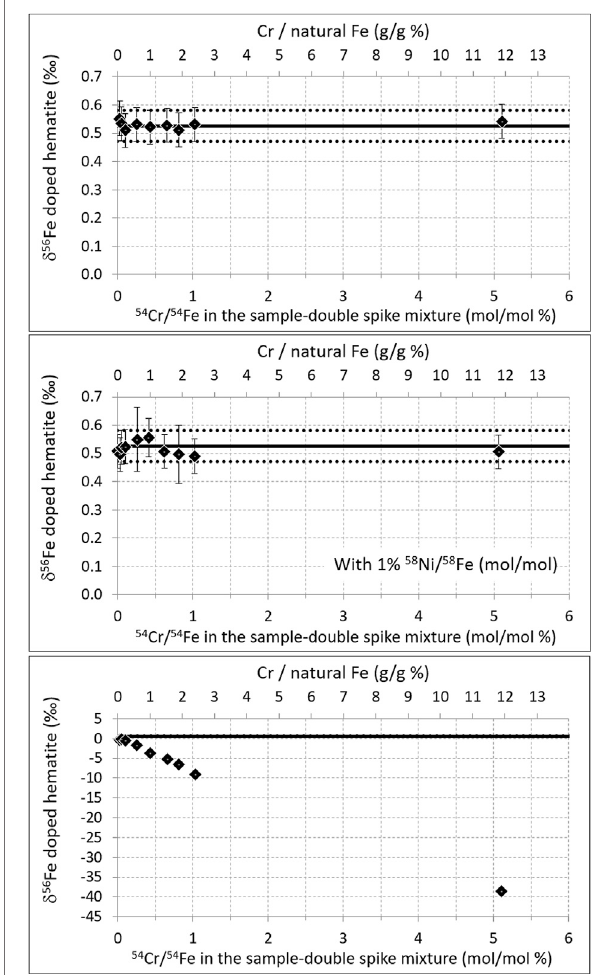
FIGURE 2 | Top: δ 56 Fe of hematite (200 ppb natural Fe) doped with variable amounts of Cr. Middle: same as top but with an addition of Ni leading to 1% 58 Ni/ 58 Fe (mol/mol) in all samples. Bottom: same as top but with no Cr interference correction (note the different vertical scale). The level of Cr doping is expressed in two ways: i) the level of Cr (all isotopes) compared to thatofnaturalFe(i.e.,nottakingintoaccountthedouble-spike,top x axis),and ii) the level of 54 Cr compared to 54 Fe in the analyzed solution, that is, in the sample double-spike mixture (bottom x axis). Diamonds are the averages of duplicate measurements (two Neptune analyses were performed for each data point reported on the plot). Error bars are 2 standard deviations of the duplicate measurements or the long-term internal precision (2SD) of our instrument (0.06 ‰ ), whichever the greatest (they are smaller than the symbol size on the bottom panel). The horizontal black lines show the δ 56 Fe of pure (un-doped) hematite measured during the same analytical session; mean value (solid line) ± 2 standard deviations (dotted lines).